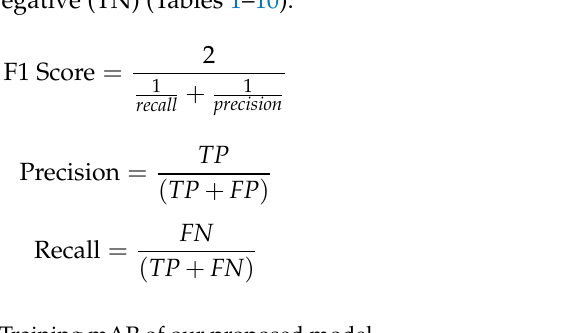
Table 1. Training mAP of our proposed model.